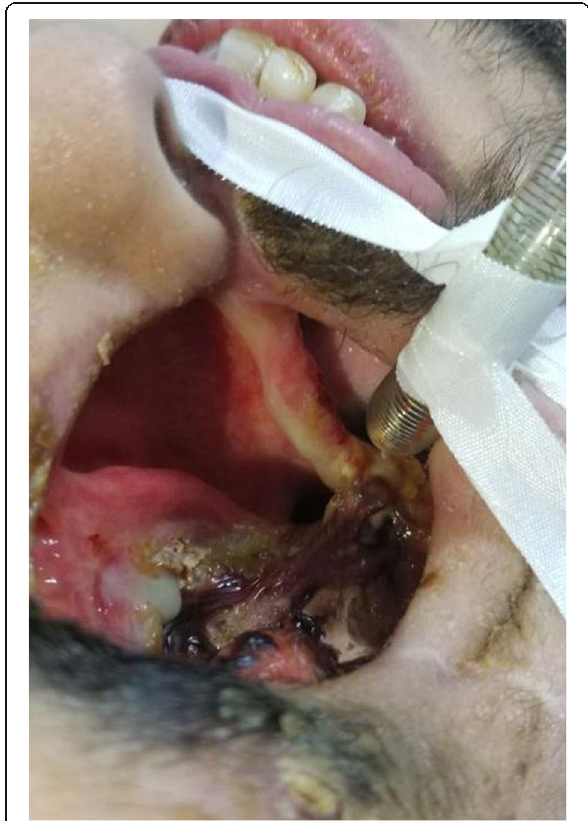
Fig. 3 Location of the endotracheal tube after